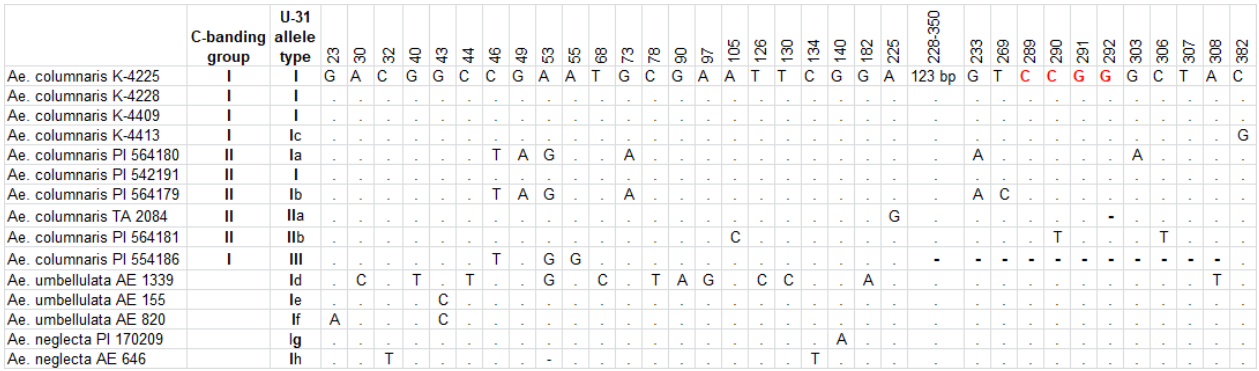
Figure 10. Nucleotide substitutions in the U31 region in 15 Ae. columnaris (U c U c X c X c ), Ae. neglecta (U t U t X t X t ), and Ae. umbellulata (UU) sequences. Dots correspond to nucleotides identical to consensus sequences. The Msp I restriction site is highlighted in red.